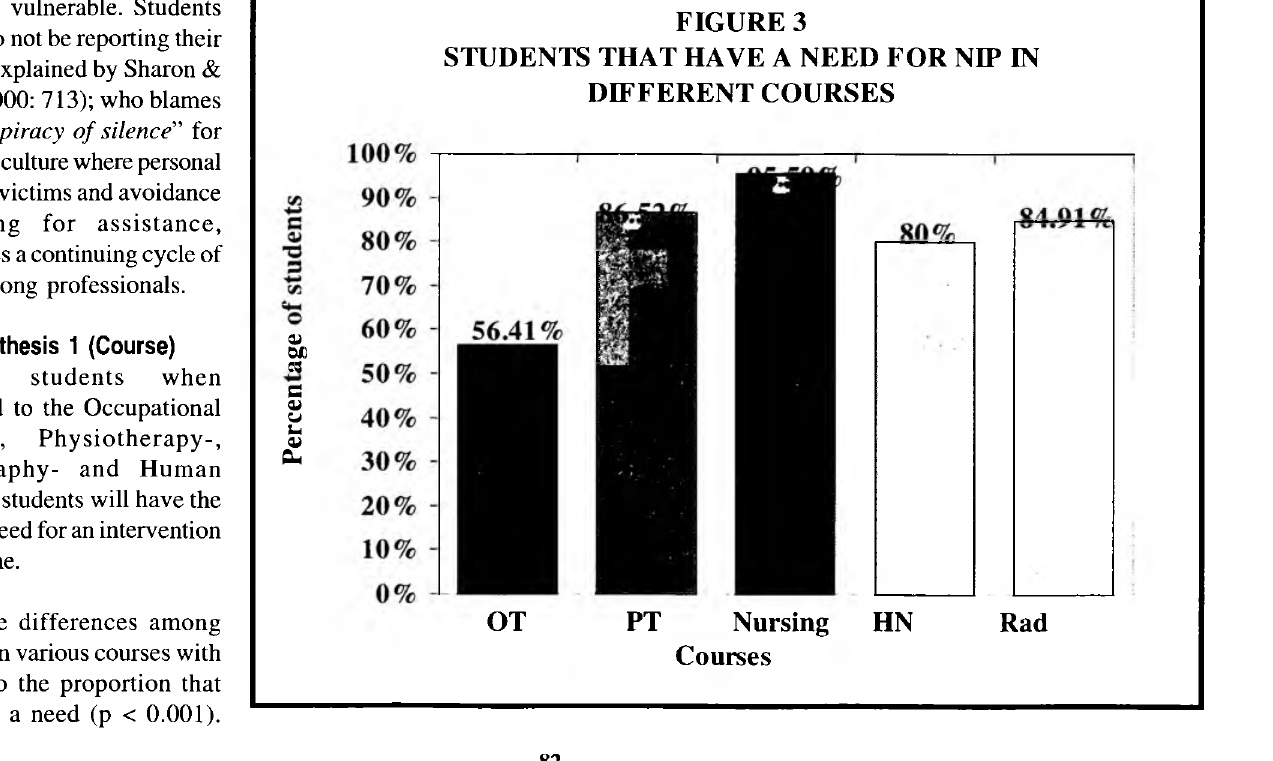
STUDENTS THAT HAVE A NEED FO R NIP IN DIFFERENT